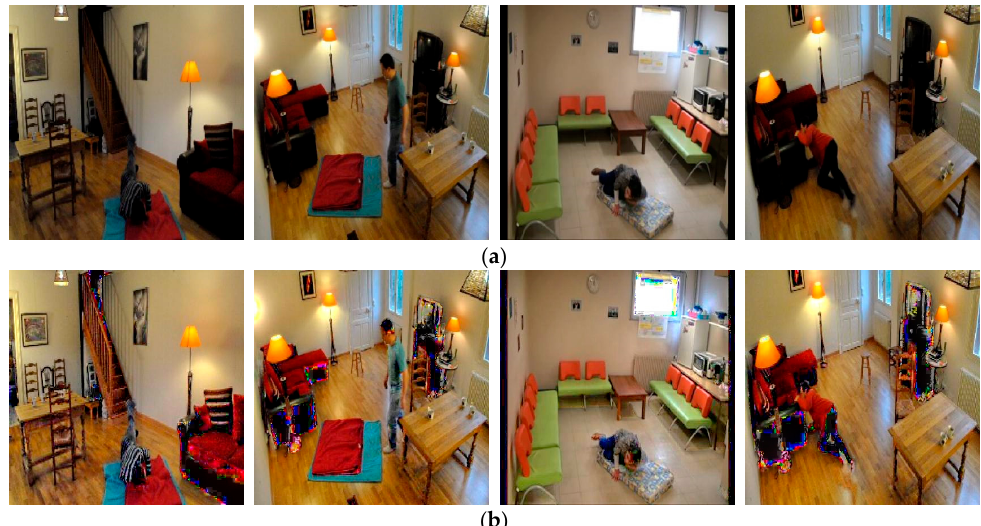
Figure 4. Examples of images from Le2i Fall Detection dataset. ( a ) The original images. ( b ) The im- ages after processing by the DUAL illumination estimation. images after processing by the DUAL illumination